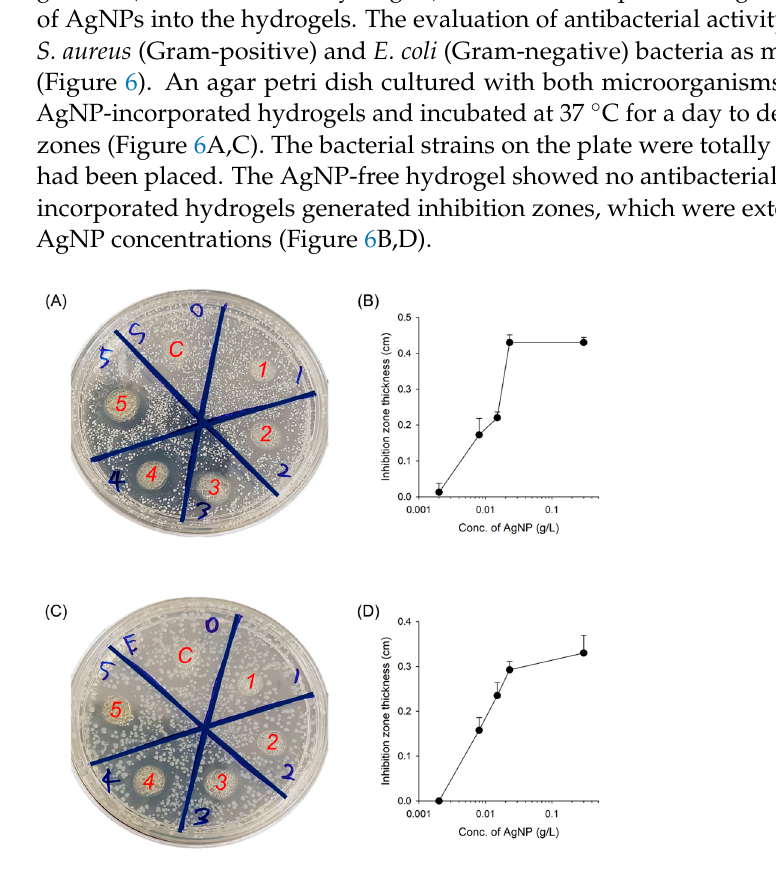
Figure 6. Bactericidal activity of AgNP-incorporated GC/CMC hydrogels. Representative image of bacterial colonies formed by ( A ) S. aureus and ( C ) E. coli with the AgNP-incorporated hydrogels placed on the agar petri dish for a day to analyze the inhibition zone. C = control, AgNP-free hydrogels. Areas 1–5 = AgNP-incorporated hydrogels at concentrations of 2, 8, 15, 23, and 30 mg L − 1 AgNPs, respectively. Quantitative inhibition zone area of bacterial colonies formed by ( B ) S. aureus and ( D ) E. coli with the AgNP-incorporated hydrogels ( n = 3).